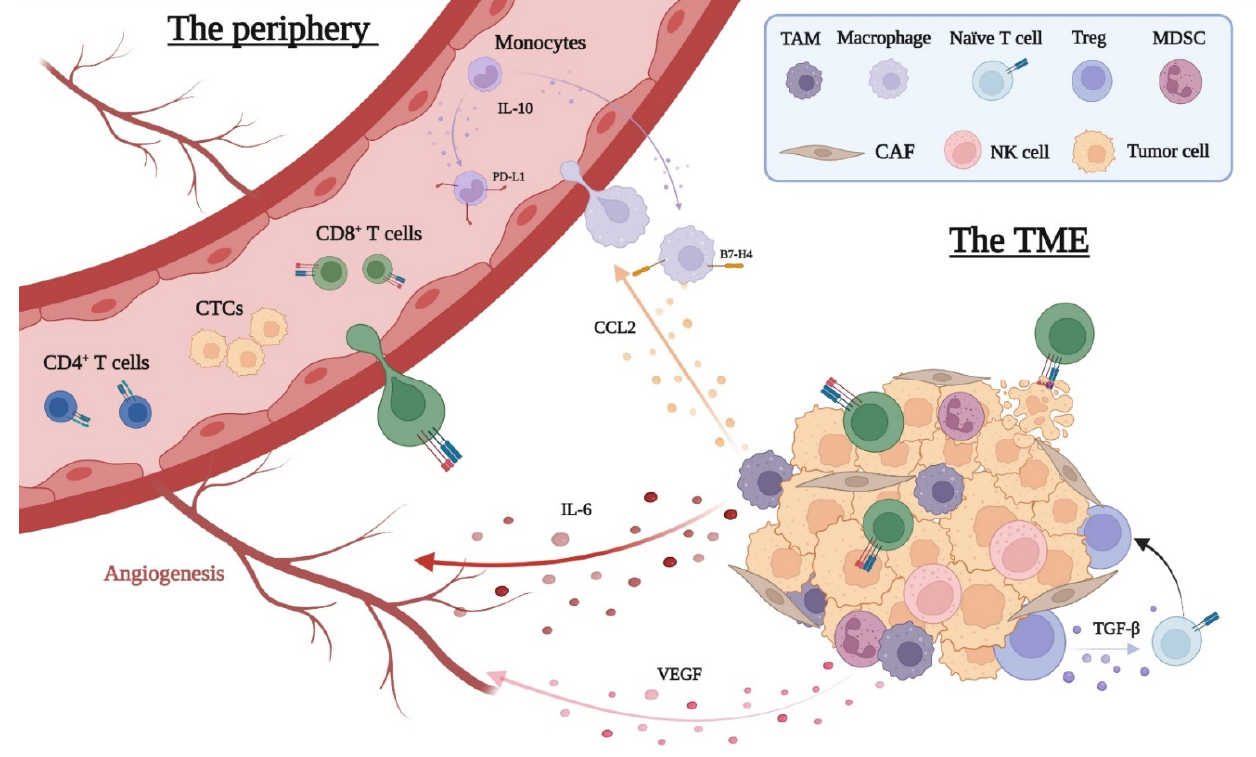
Figure 2. The interplay between the peripheral immune system and the tumor microenvironment (TME). CAF, cancer-associated fibroblast; CCL, CC chemokine ligand; CTC, circulating tumor cell; IL, interleukin; MDSC, myeloid-derived suppressor cell; PD-L1, programmed death-ligand 1; TAM, tumor-associated macrophage; Treg, regulatory T cell; VEGF, vascular endothelial growth factor. Created with BioRender.com (accessed on 7 June 2022).